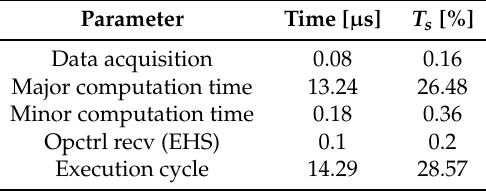
Table 3. Time used per T s